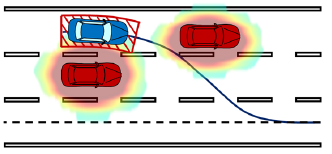
Figure 15. An illustration of parking action.